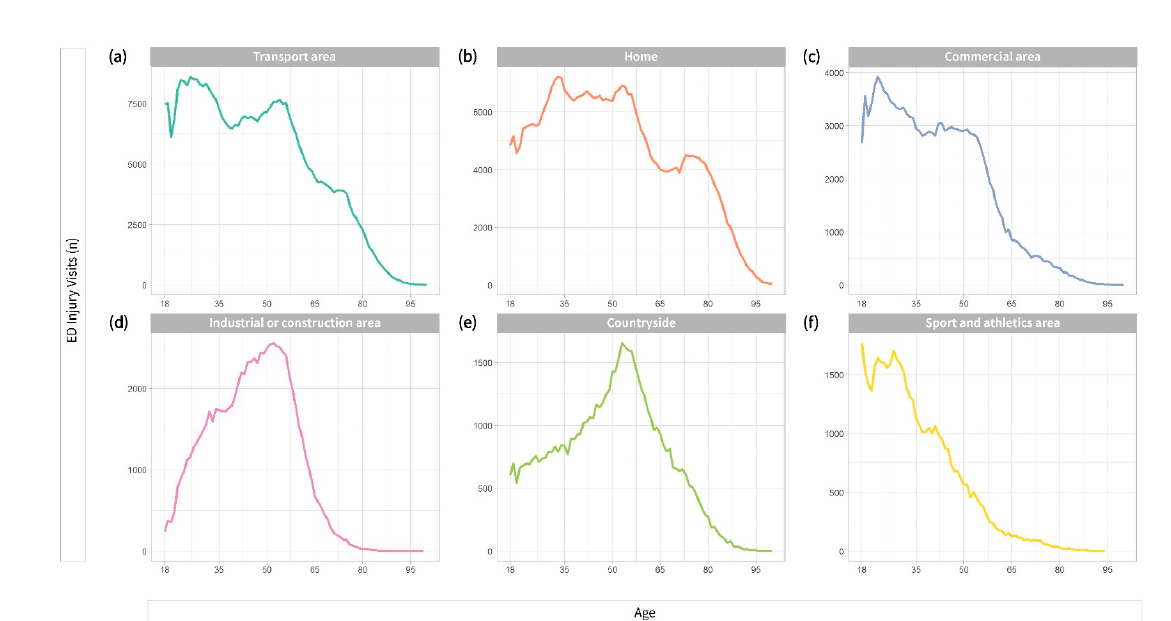
Figure 3. Six of the most common places of injury by age. ( a ) Number of injuries in the transport area (including roads) by age; ( b ) number of injuries at home by age; ( c ) number of injuries in commercial area by age; ( d ) number of injuries in industrial or construction facilities by age; ( e ) number of injuries occurring countryside (including sea and river) by age; ( f ) number of injuries in sport and athletics area by age. ED: Emergency department.